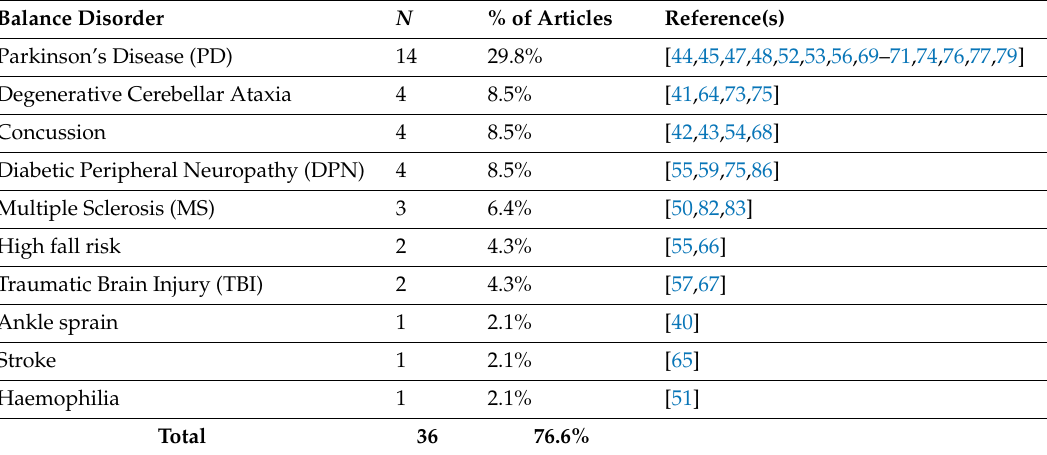
Table 4. Summary of the balance disorders reported in the included